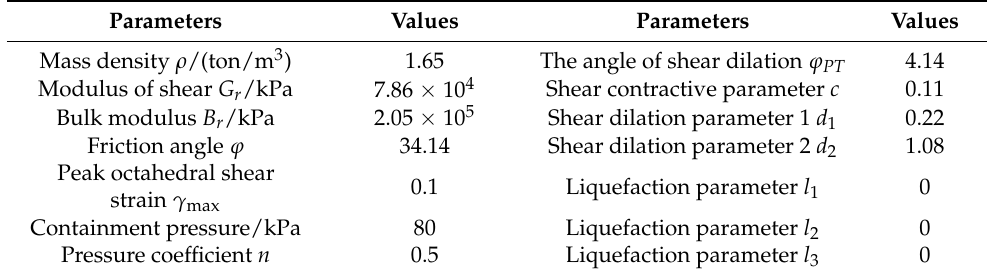
Table 2. The parameters of the PDMY model for sandy soil.